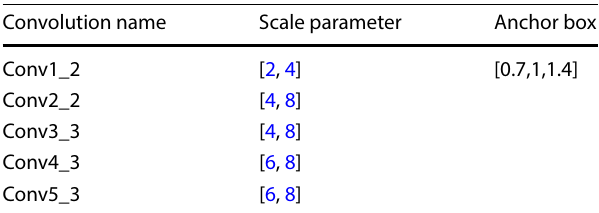
Table 2 The multi-scale analysis convolution parameters of VGG16